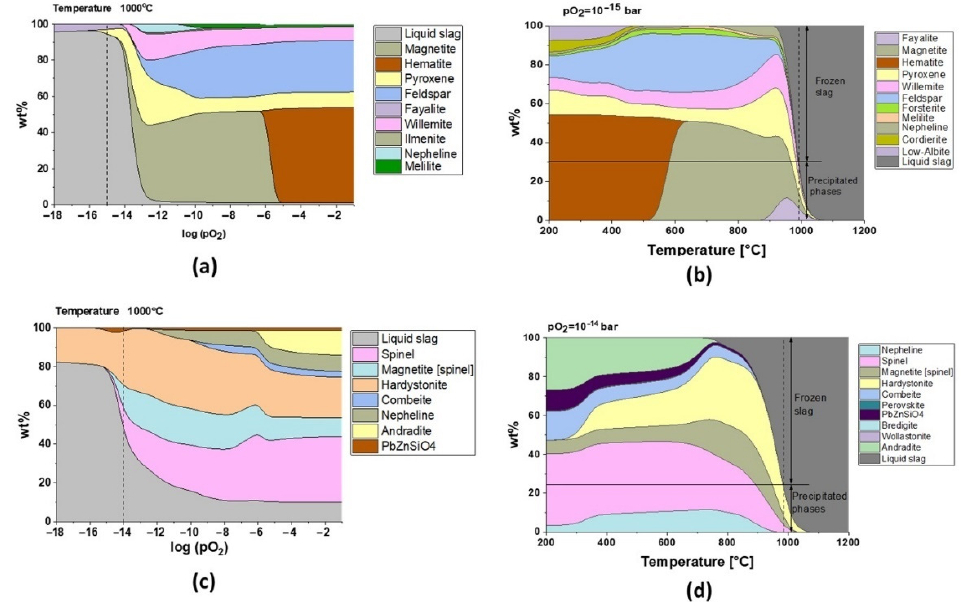
Figure 7. Phase formation as a function of ( a ) pO 2 for slag 1 (at 1000 °C), ( b ) temperature for log (pO 2 ) = − 15 bar for slag 1, ( c ) pO 2 for slag 2 (at 1000 °C), and ( d ) temperature for log (pO 2 ) = − 14 bar for slag 2.